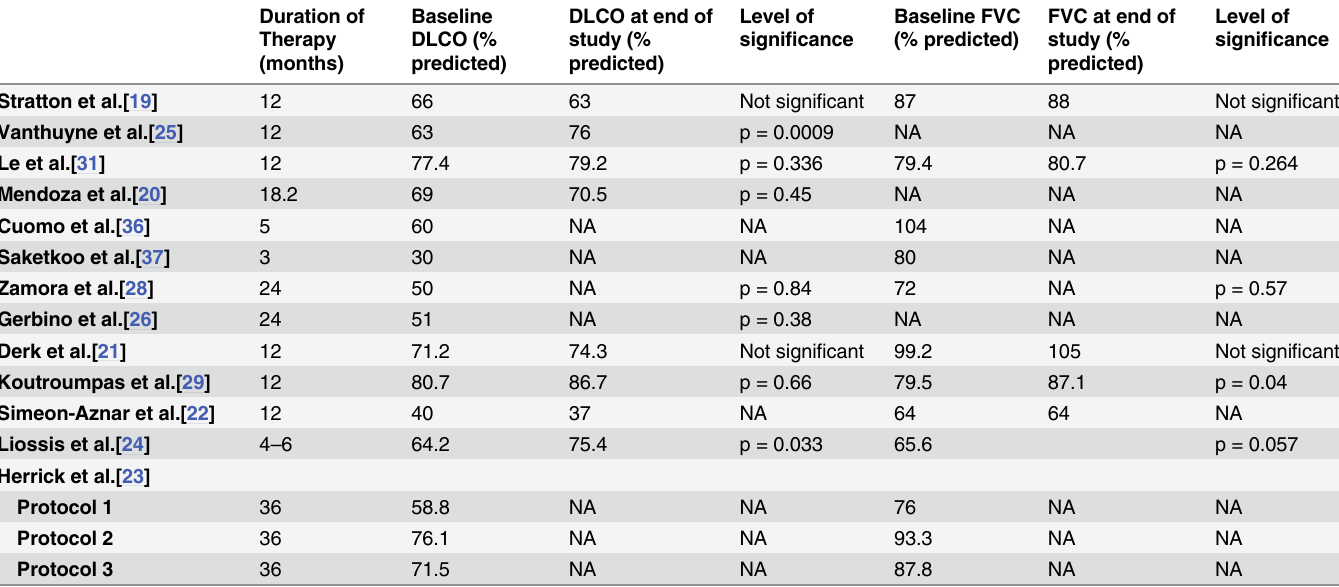
Table 3. Effect of mycophenolate on pulmonary